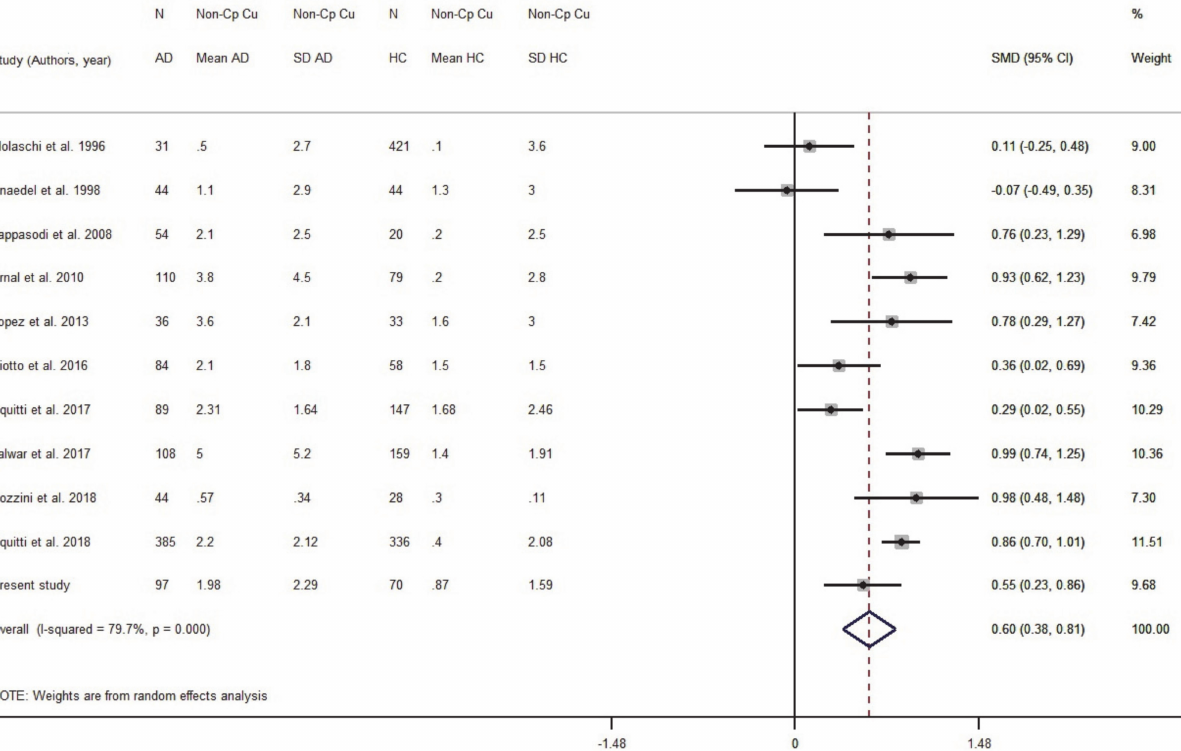
Figure 5. Standardized mean difference (SMD) computed from the studies on Non-Cp Cu( µ mol/L) in AD patients and HC subjects when considering studies with a Cu:Cp ratio lower than 6 and higher than 8. SMDs between AD subjects and controls are represented by squares, whose sizes are proportional to the sample size of the relative study. The whiskers represent the 95% confidence interval (CI). The diamond represents the pooled estimate based on the random-effects model, with the center representing the point estimate and the width indicating the associated 95% CI. Abbreviations: PY, publication year; N, number; SD, standard deviation; HC, healthy